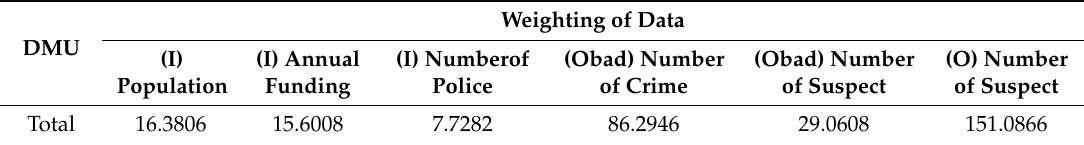
Table 9. Weighting of